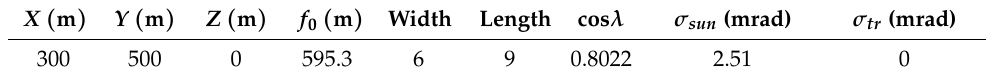
Table 1. Heliostat